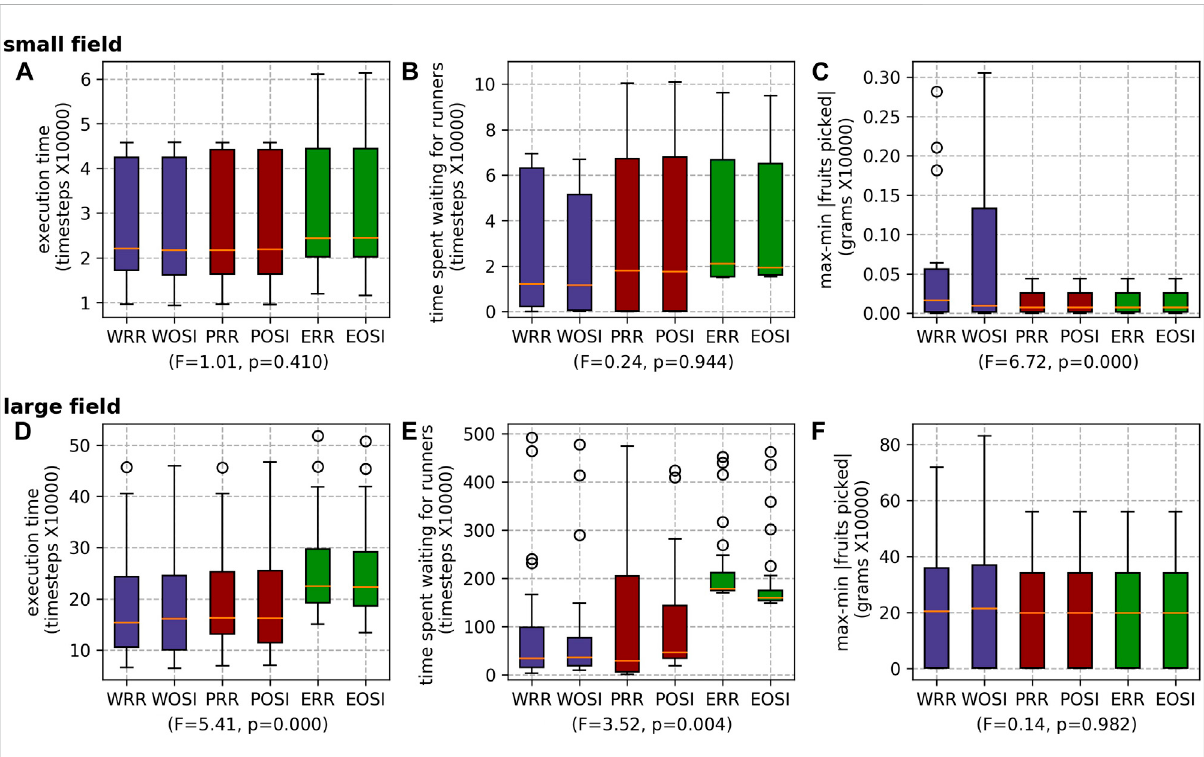
FIGURE 14 Results for the different runner scheduling strategies for both farms: the small fi eld (A) execution time, (B) waiting time and (C) max-min |fruits picked|; and the large fi eld (D) execution time, (E) waiting time and (F) max-min |fruits picked|.